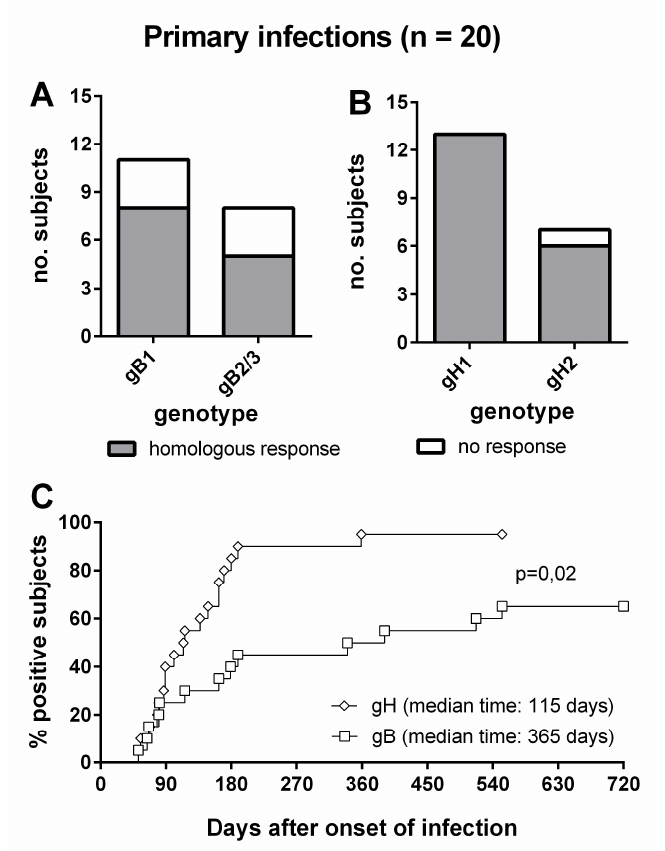
Figure 6. Genotype-specific IgG antibody to gB and gH in subjects with primary HCMV infection. ( A ) gB genotype-specific IgG response in subjects infected by gB1- and gB2/3-HCMV. ( B ) gH genotype-specific IgG response in subjects infected by gH1- and gH2-HCMV. ( C ) Comparative time to development of genotype-specific IgG response to gB and gH.